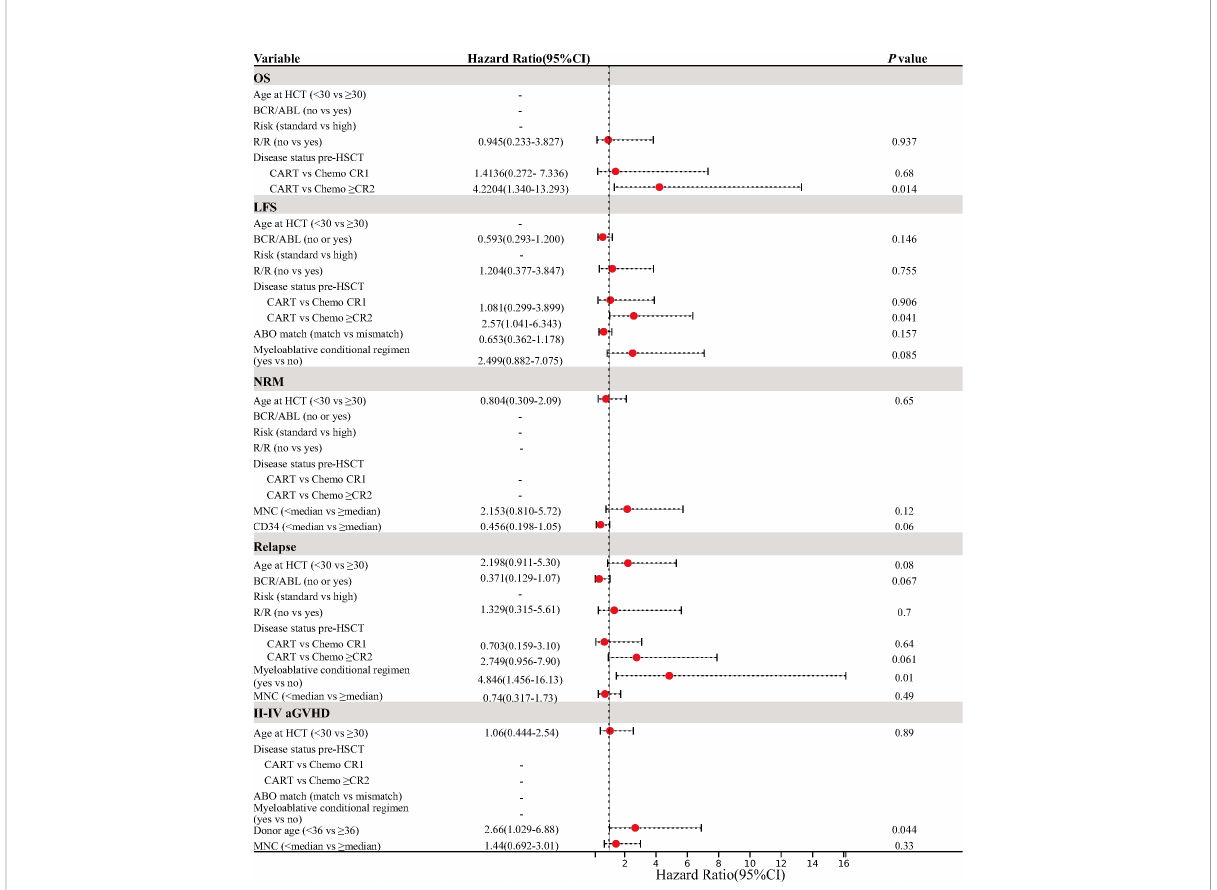
FIGURE 3 Multivariate analysis for OS, LFS, NRM, relapse, and II – IV aGVHD. OS, overall survival; LFS, leukemia-free survival; NRM, non-relapse mortality; aGVHD, acute graft-versus-host